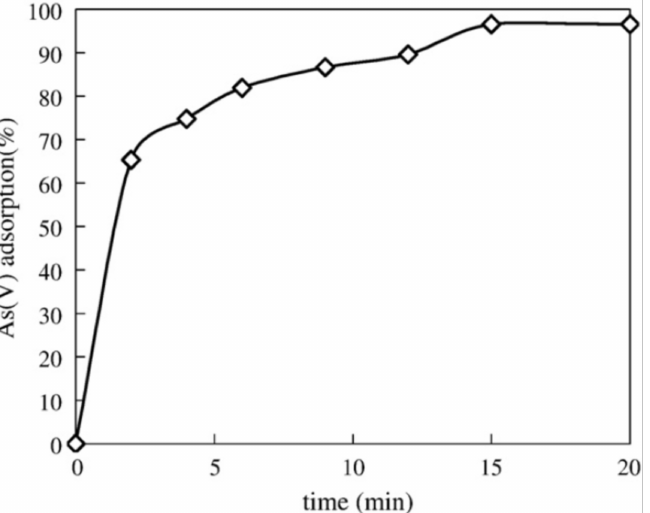
Figure 9. The effect of time on the adsorption of As(V) by Fe(III) LECCA at As(V) concentration: 1 mg/L; pH: 7.0; room temperature: 25 ◦ C [133]. Copyright: